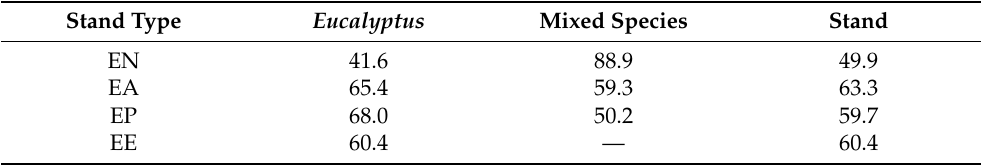
Table 3. Preservation rate of pure and mixed- Eucalyptus plantations (unit: %).